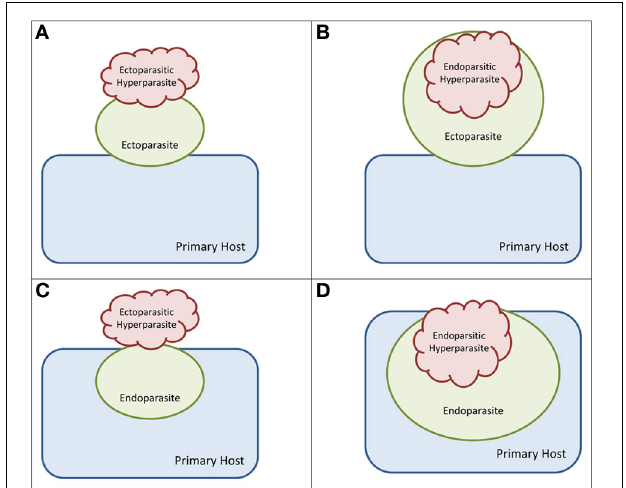
FIGURE 1 | Types of hyperparasitism. Blue—primary host, green—parasite, red—hyperparasite. (A) epibiotic hyperparasite of ectoparasite. This type can be found for example in the interaction of the hyperparasite Rhizophydium parasiticum (Chytridiomycota), its and its (facultative) parasites host Rhizophlyctis rosea . (B) Endobiotic hyperparasite of ectoparasite host. This is the most commonly described mode of hyperparasitsm seen in many Rozella species (Cryptomycota) or Woronina spp. (Phytomyxea). (C) Epibiotic hyperparasite of endoparasite host. E.g., Rhizophyidum carpophilum (Chytridiomycota) on Olpidiopsis sp. (oomycetes) and Synchytrium sp. (chytrid). (D) Endobiotic hyperparasite of endoparasite host. E.g., the hyperparasitic chytrid Phlyctochytrium synchytrii in the plant pathogen Synchytrium endobioticum